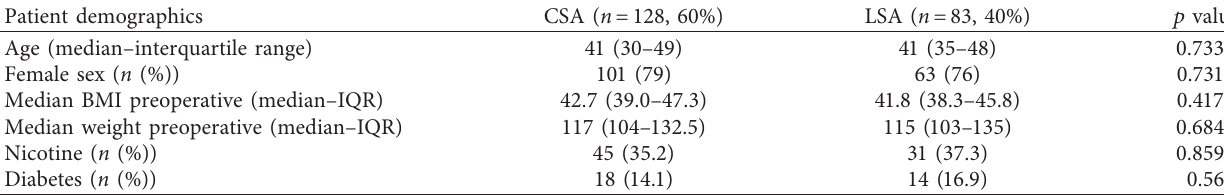
Table 2: Patient demographics.